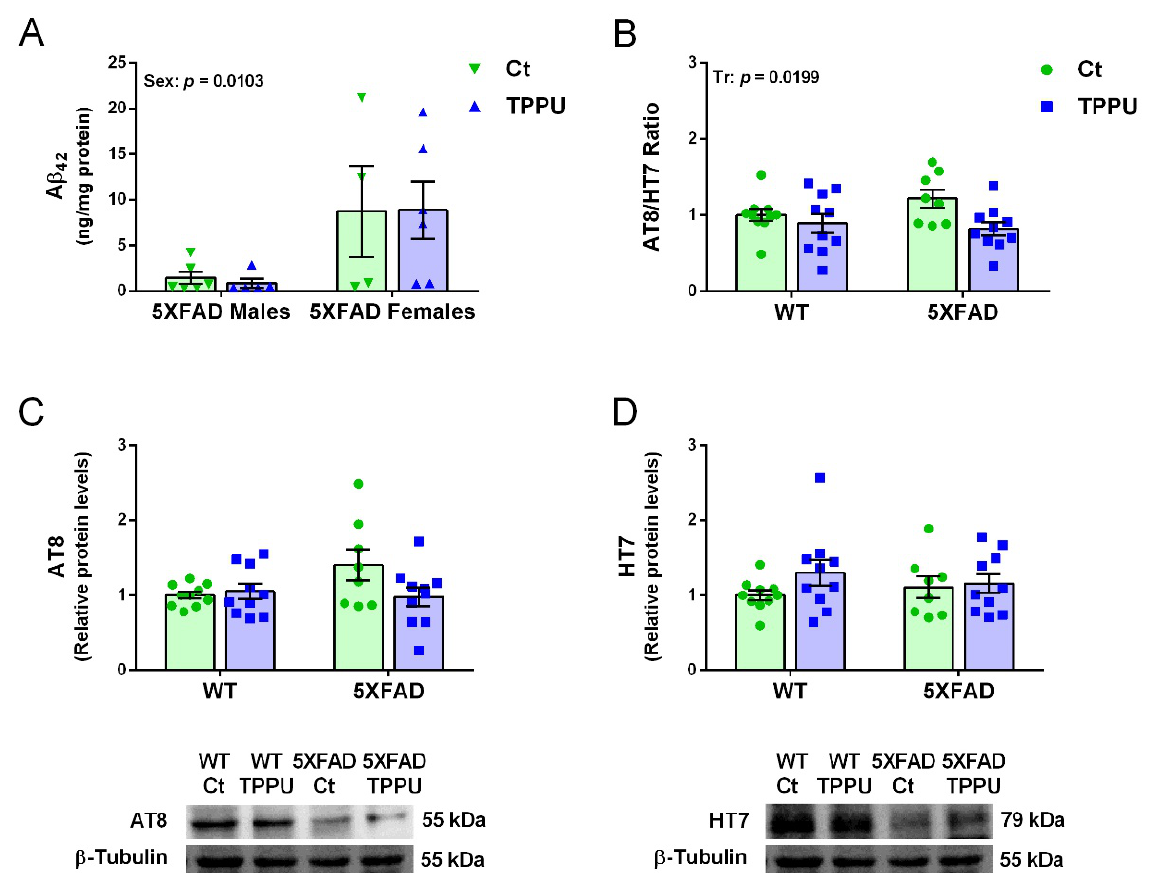
Figure 5. Amyloid β 42 (A β 42 ) and hyperphosphorylated tau (p-tau) in 2-month-old 5XFAD mice from litters with maternal TPPU treatment or control (Ct). ( A ) Differential A β 42 concentration in male and female 5XFAD mice; ( B ) ratio of protein levels of p-tau immunodetected by AT8 antibody (values shown in ( C )) and total tau immunodetected by HT7 antibody (values shown in ( D )) in WT and 5XFAD offspring. Representative blots are shown below the corresponding histograms in ( C , D ). ( A ) Cerebral cortex samples; ( B – D ) hippocampus samples. Values are mean ± SEM (( A ) n = 4–6; ( B – D ) n = 8–10). Statistics: ANOVA, effect of sex (Sex) in ( A ) and treatment (Tr) in ( B ), p values of significant factors are indicated in the corresponding graphs; borderline interaction effect (G × Tr) in ( C ) (see text).